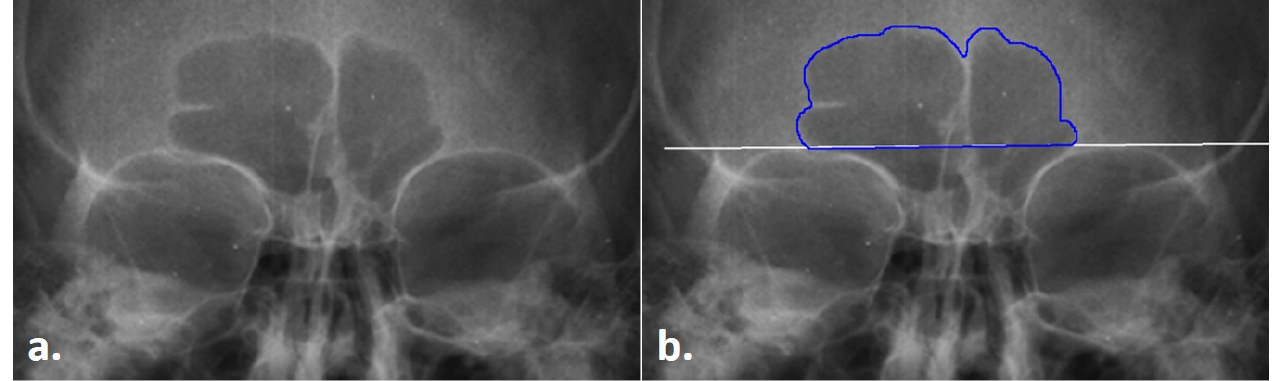
Figure 1. Radiograph of the frontal sinus; ( a ) untreated radiograph, ( b ) frontal sinus with the outline (blue) and supraorbital line